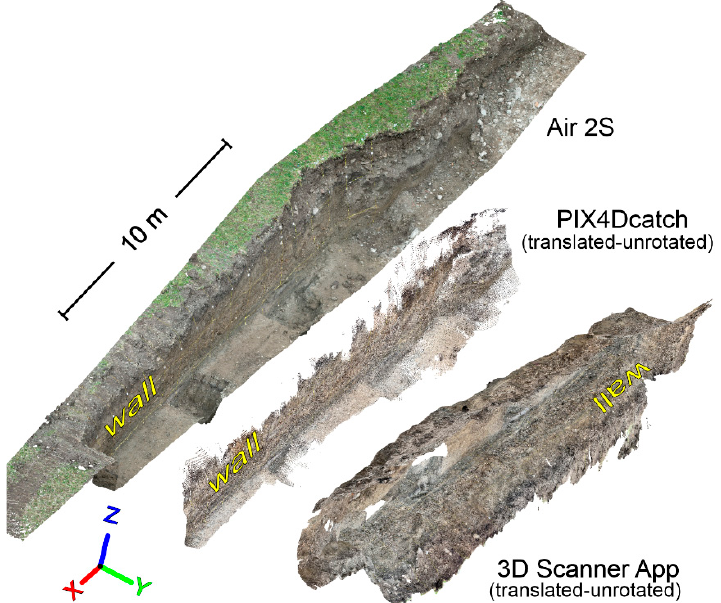
Figure 3. Visual comparison in CloudCompare of the Air 2S model with the PIX4Dcatch and 3D Scanner App models after translation next to the Air 2S model.